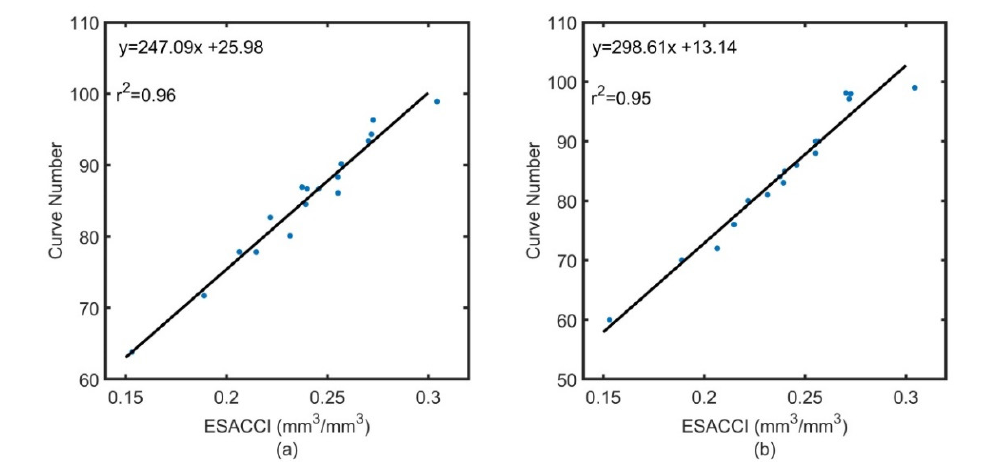
Figure 3. CN correlation with soil moisture data for observed ( a ) and Global Precipitation Measurement (GPM) events ( b ). (GPM) events ( b